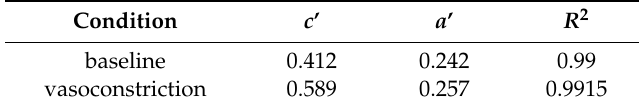
(cid:48) · ( a (cid:48) = a /2 )